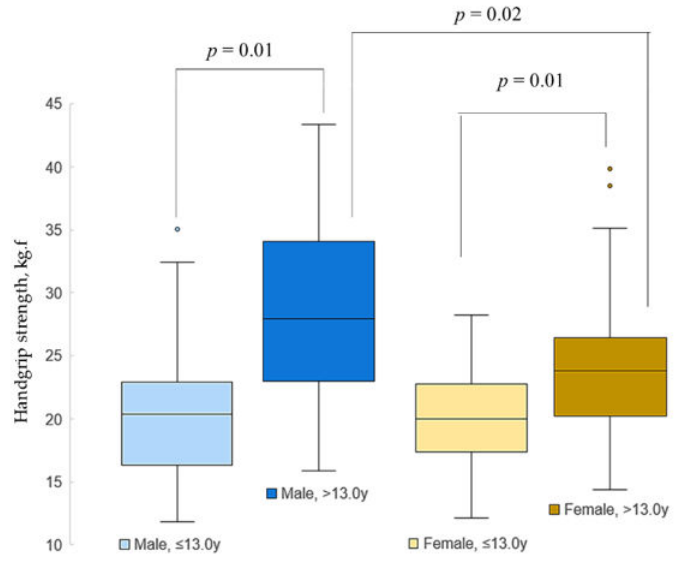
Figure 2. Handgrip strength in female and male according to different age classes ( ≤ 13 or >13 years).